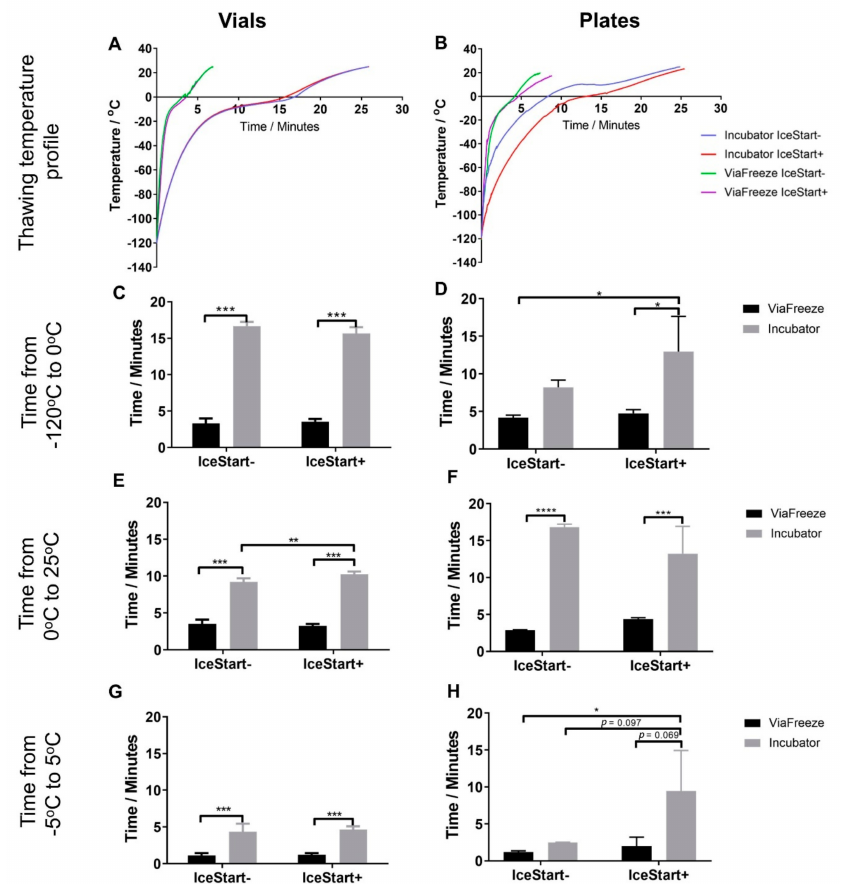
Figure 2. Thawing profiles and time across significant temperature zones. Vial ( A ) and 96-well plate ( B ) cryosolution temperature during warming (fast warming provided by ViaFreeze device, slow warming provided by incubator). Slow thaw / IND-: Blue, Slow thaw / IND + : Red, Fast thaw IND-: Green, Fast thaw IND + : purple ( C , D ) Time from long-term storage temperature to theoretical melting point. ( E , F ) Time from theoretical melting point to room temperature towards acceptable culture temperature. ( G , H ) Time across phase change temperature range—solid to liquid. ( n = 2 replicates + 3 repeats for each condition * p ≤ 0.05, ** p ≤ 0.01, *** p ≤ 0.001, **** p ≤ 0.0001, bars represent ± SD). Legend applies to both graphs on